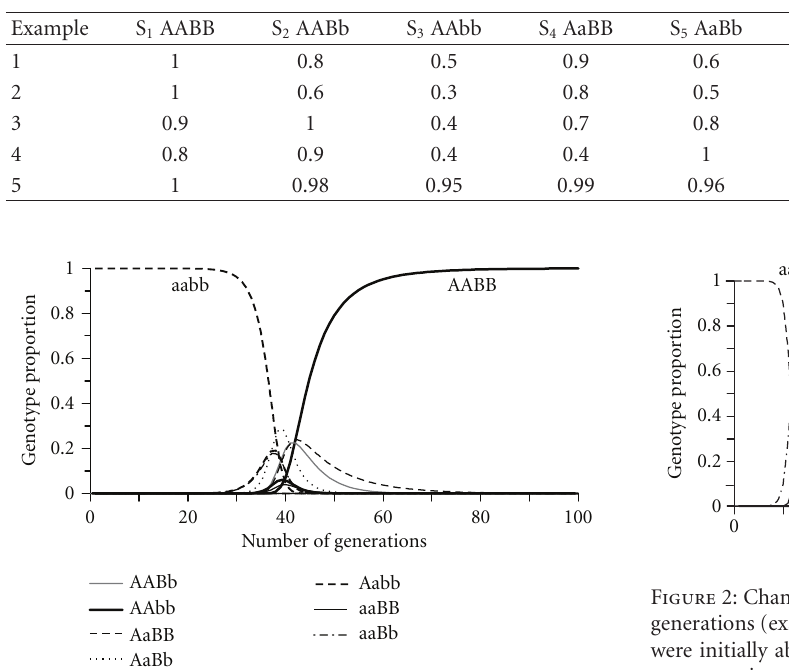
Figure 1: Change in proportions of the nine genotypes during 100 generations (example 1) with indiscriminate mating in which there were initially about 10 7 (0.9999998 aabb) individuals and initially one mutation of a to A (0.0000001 Aabb) and one of b to B (0.0000001 aaBb) resulting in 0.9994339 AABB after 100 genera- tions. Relative survival of each genotype was S 1 = 1 (AABB), S 2 = 0.8 (AABb), S 3 = 0.5 (AAbb), S 4 = 0.9 (AaBB), S 5 = 0.6 (AaBb), S 6 = 0.3